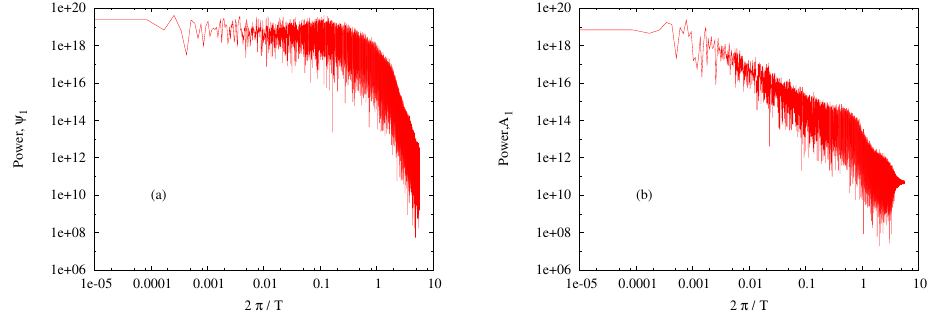
Fig. 3. Temporal variation of the mean values of the oceanic modes A i for (a) θ ∗ = 0 . 077, δ = 0 . 001938 and (b) θ ∗ = 0 . 14, δ = 0 . 001938. Fig. 3. Convergence of the mean values of the oceanic modes A i for (a) θ ∗ = 0 . 077 , δ = 0 . 001938 and (b) θ ∗ = 0 . 14 , δ = 0 . 001938 .